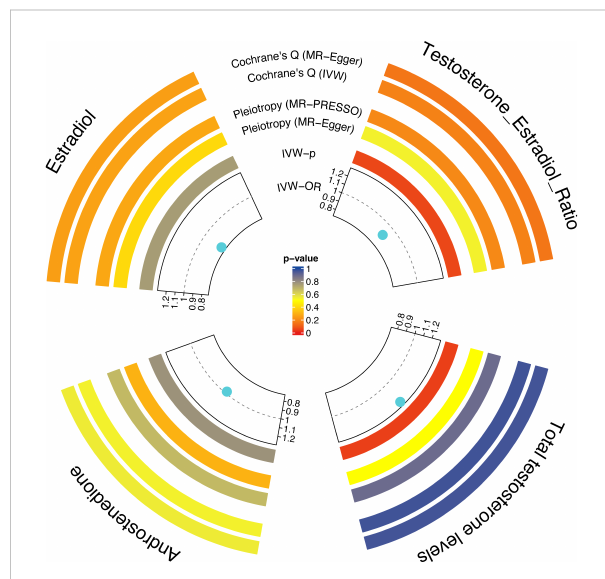
FIGURE 2 The causal effect of each sex hormone (TT, A4, E2, and T/E2) on osteoporosis. Gray dotted line: OR=1. TT, total testosterone; A4, androstenedione; E2, estradiol; T/E2, testosterone/17 b